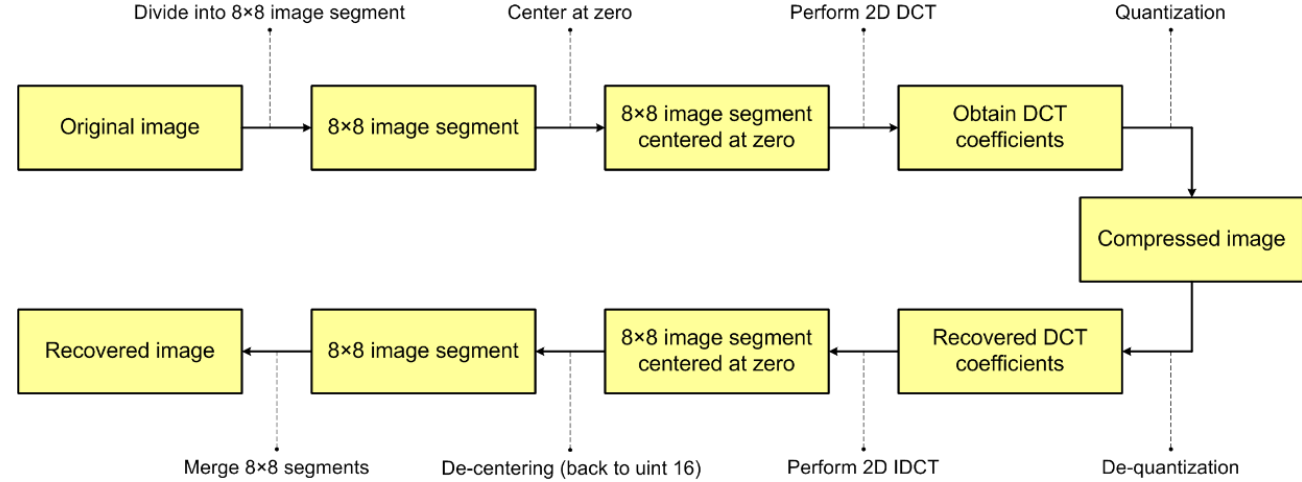
Figure 2. Block diagram illustration of JPEG-based image compression and recovery